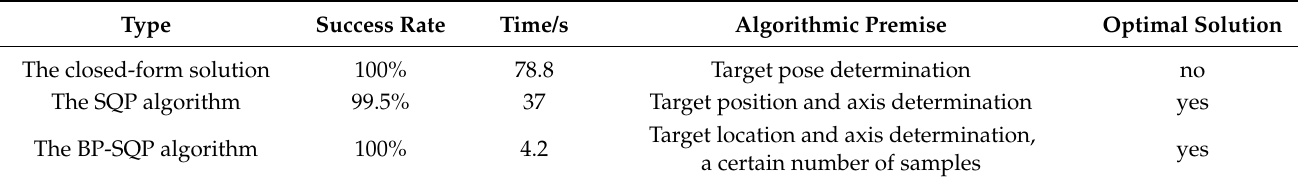
Figure 11. BP-SQP solution of inverse solution. Table 1. Comparison of results. Table 1. Comparison of